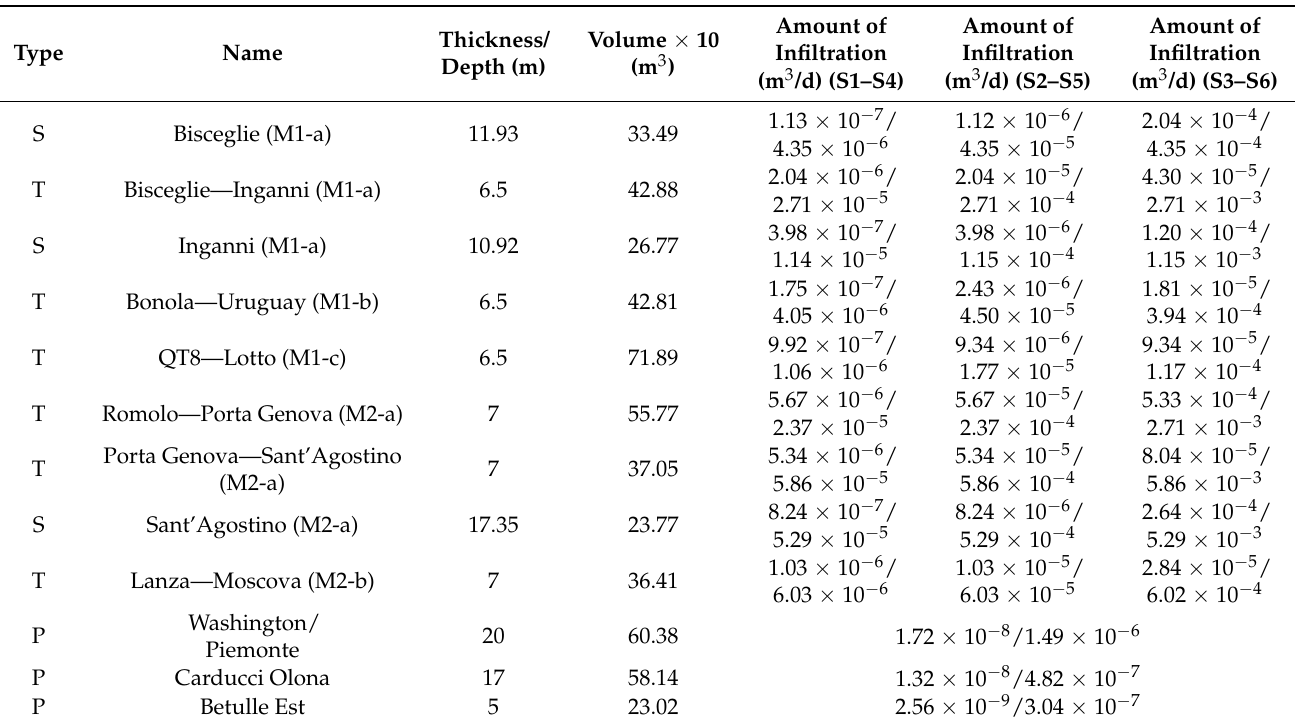
Table 5. Comparison of GW inflows into UIs (m 3 /d) for the initial scenario (S1–S3, intact walls) and their corresponding final scenario (S4–S6, leaky walls). Please remember that, for car parks, K was always set equal to 1.16 × 10 − 13 m/d for S1–S3 and to 1.16 × 10 − 9 m/d for wall fractures in S4–S6. S means station, T means tunnel, P means park. Depth (m) has been provided for subway stations and parks, as they are designed from the ground field; as for tunnels, since they are not designed from the ground field, thickness was provided rather than